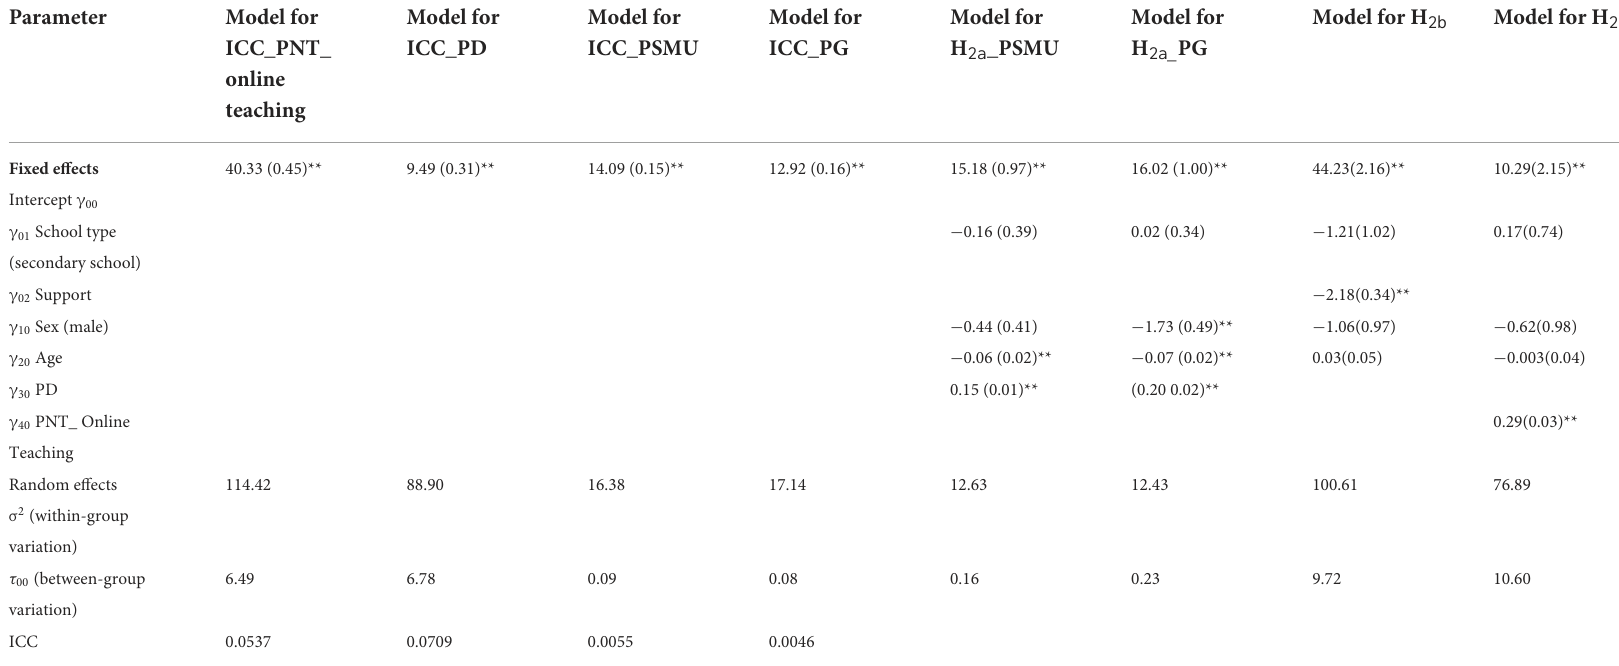
TABLE 3 Unstandardized coefficients (SE) obtained from hierarchical linear modeling using robust SEs. Parameter Model for Model for Model for Model for Model for Model for Model for H 2b Model for H ICC_PNT_ ICC_PD online teaching